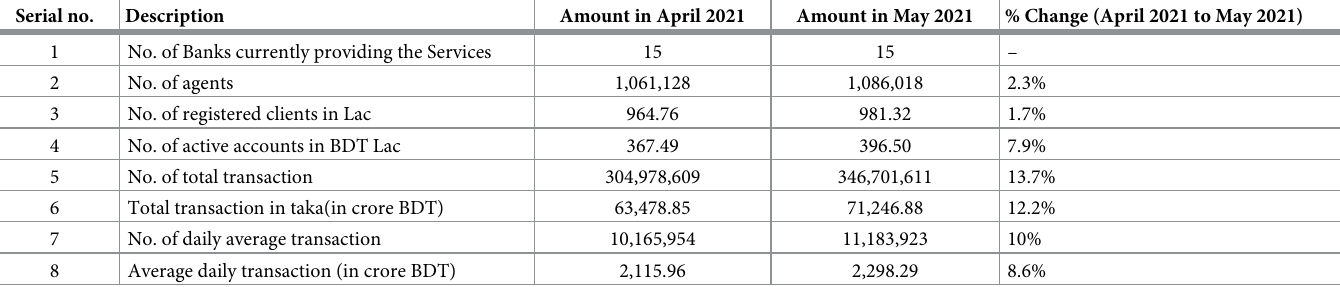
Table 1. Summarized statistics of MFS activities in Bangladesh for two consecutive months. Data source: Bangladesh Bank [24]. Serial